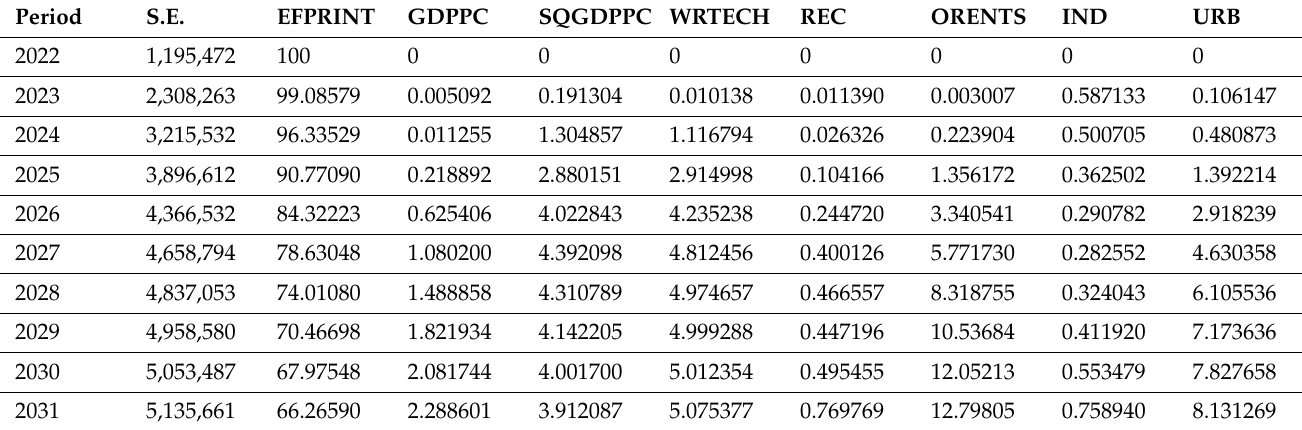
Table 9. VDA estimates of the ecological